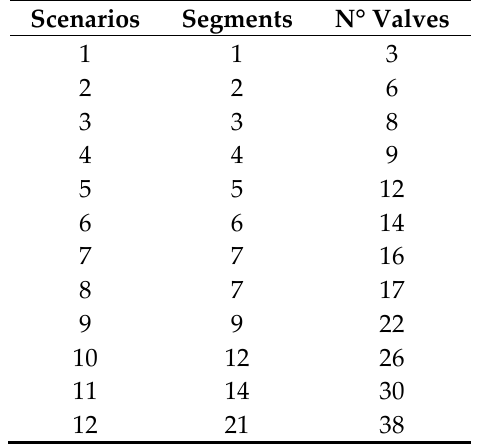
Table 1. Different scenarios obtained with different numbers of shut-off valve.